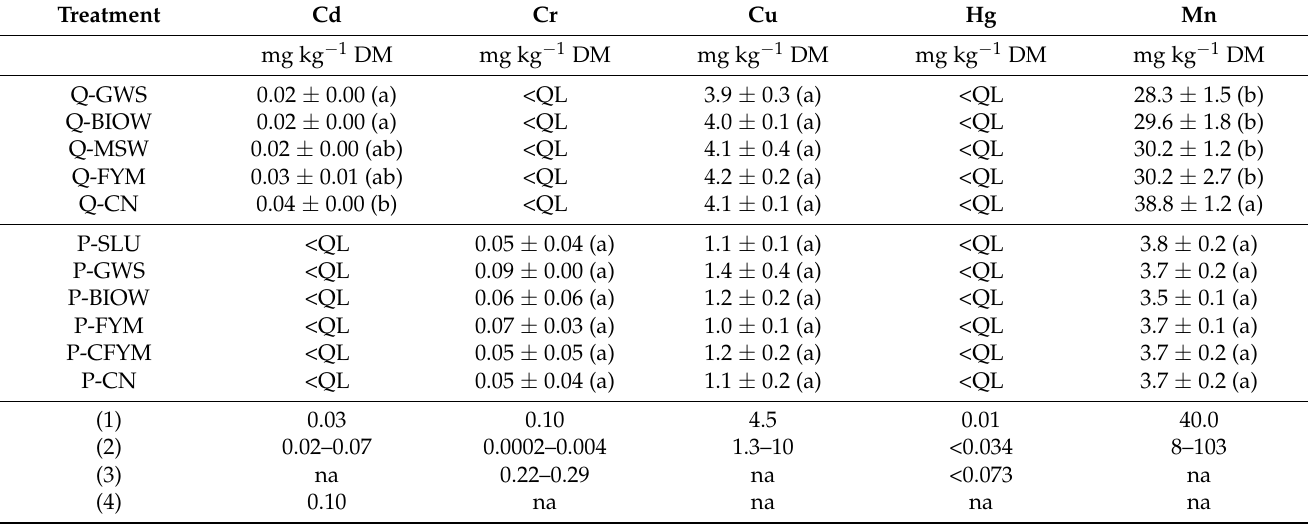
Table 8. Trace element concentrations in consumable grains (mg kg − 1 DM, DM for dry matter), with the following data presented: mean values ± standard deviation of the four replicates (in each site, abc letters stand for significant difference between treatments with Newman–Keuls and Kruskal–Wallis tests). See Figures 1 and 2 for treatments signification. <QL: at least half of values were lower than the quantification limit. na for not